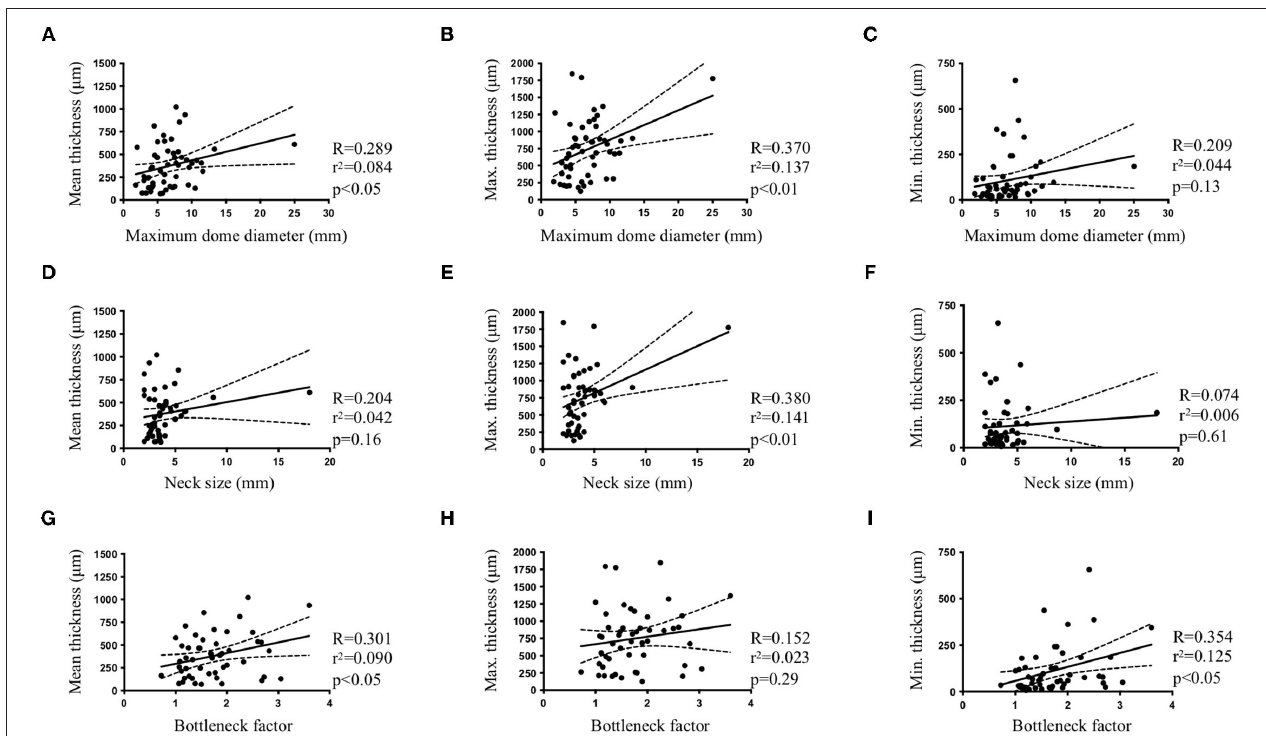
FIGURE 3 | Intracranial aneurysm characteristics and IA wall thickness. Pearson correlations between maximum dome diameter (A–C) , neck size (D–F) or bottleneck factor (G–I) and mean (A,D,G) , maximum [Max. (B,E,H) ] or minimum [Min. (C,F,I) ] IA wall